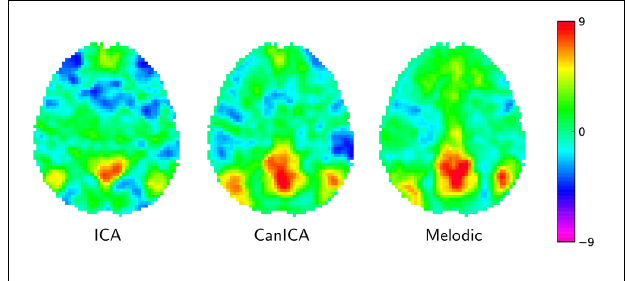
FIGURE 4 | Default mode network extracted using different approaches: left : the simple Concat-ICA approach detailed in this article; middle : CanICA, as implemented in nilearn; right : Melodic’s concat-ICA. Data have been normalized (set to unit variance) for display